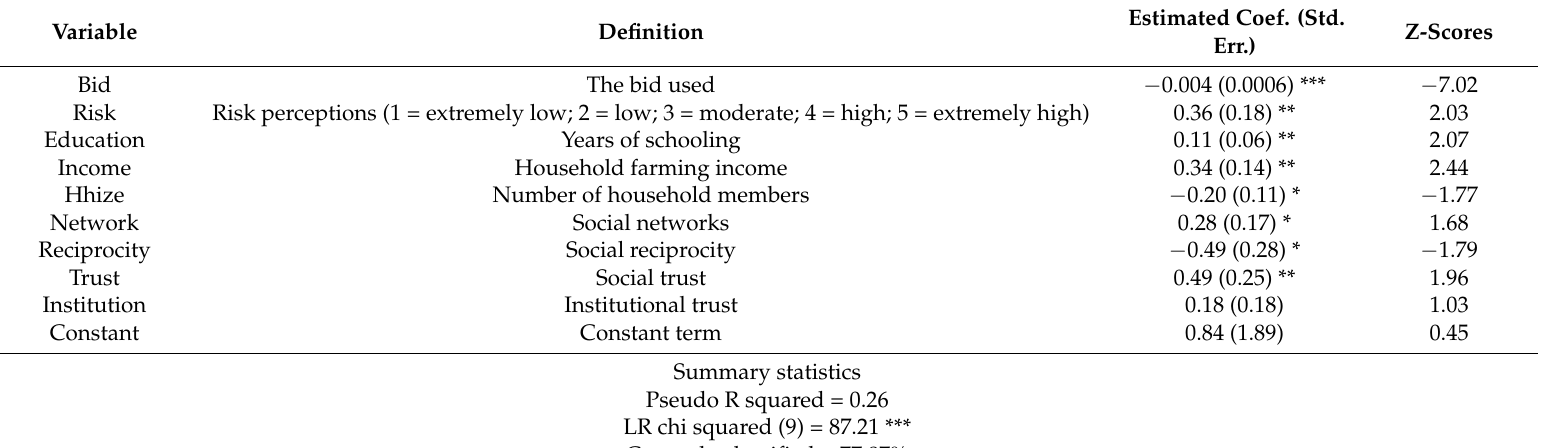
Table 4. Estimated coefficients of logit